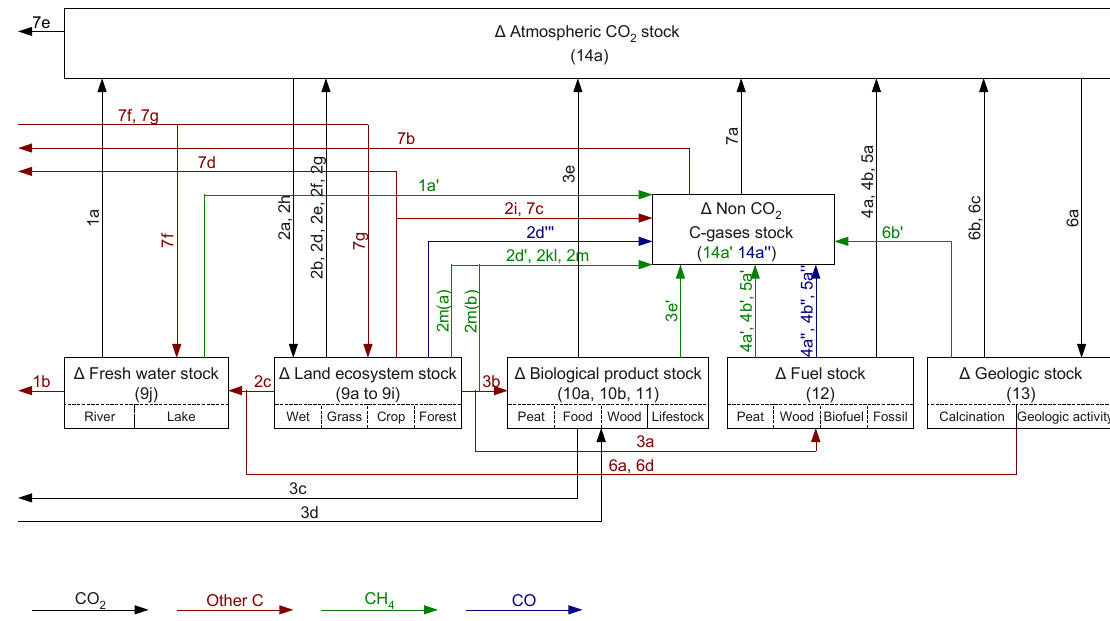
Fig. 2. Accounting framework of the C-balance. The framework is based on a mass balance approach and, given that for Europe most of the components have been independently estimated, different schemes may be used to estimate the variable of interest, i.e. the net land to atmosphere exchange. In this study, we applied three quasi-independent accounting schemes based on (1) atmospheric inversions, (2) flux measurements and (3) carbon inventories. Black arrows indicate CO 2 fluxes, green CH 4 fluxes, blue CO and red indicates other C-fluxes. Labelling is explained in Table